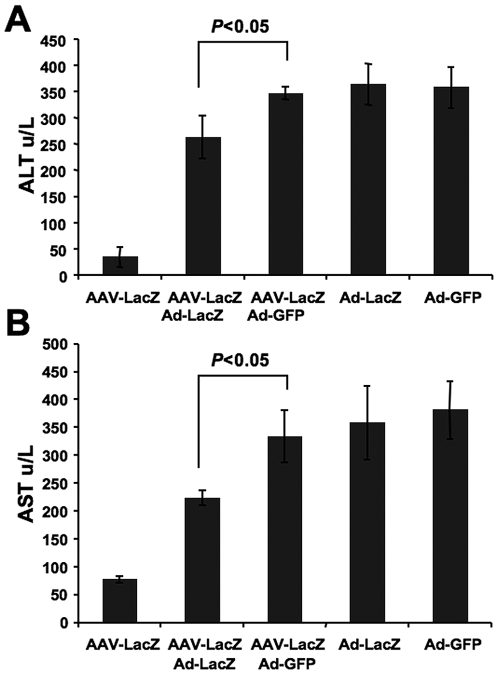
Systemic levels of liver enzymes as indicators of liver damage.Systemic levels of AST (aspartate aminotransferase) and ALT (alanine aminotransferase) liver enzyme levels were measured from plasma for all experimental groups of C57BL/6 mice 10 days after Ad-LacZ or Ad-GFP delivery (i.e. during the acute inflammatory response in the liver) and compared to data from AAV-LacZ transduced mice that did not receive Ad vectors. Data are average±SD for n = 4 mice/experimental group.